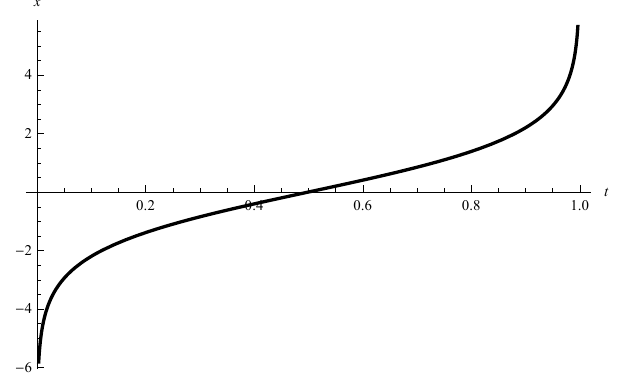
(cid:16) (cid:17) u 1 − u